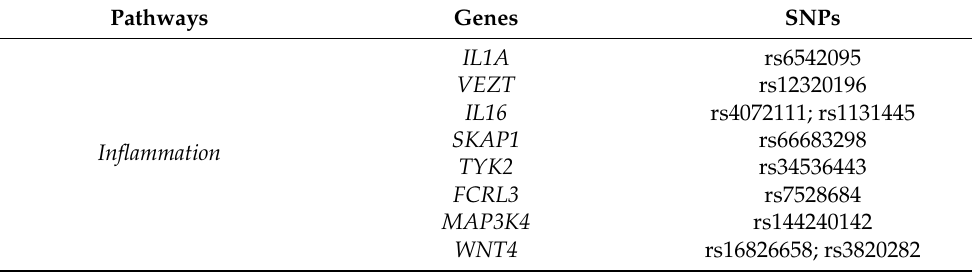
Table 1. Genes involved in inflammatory processes or modulated by inflammatory pathways observed overlapping or located near loci involved in the susceptibility to